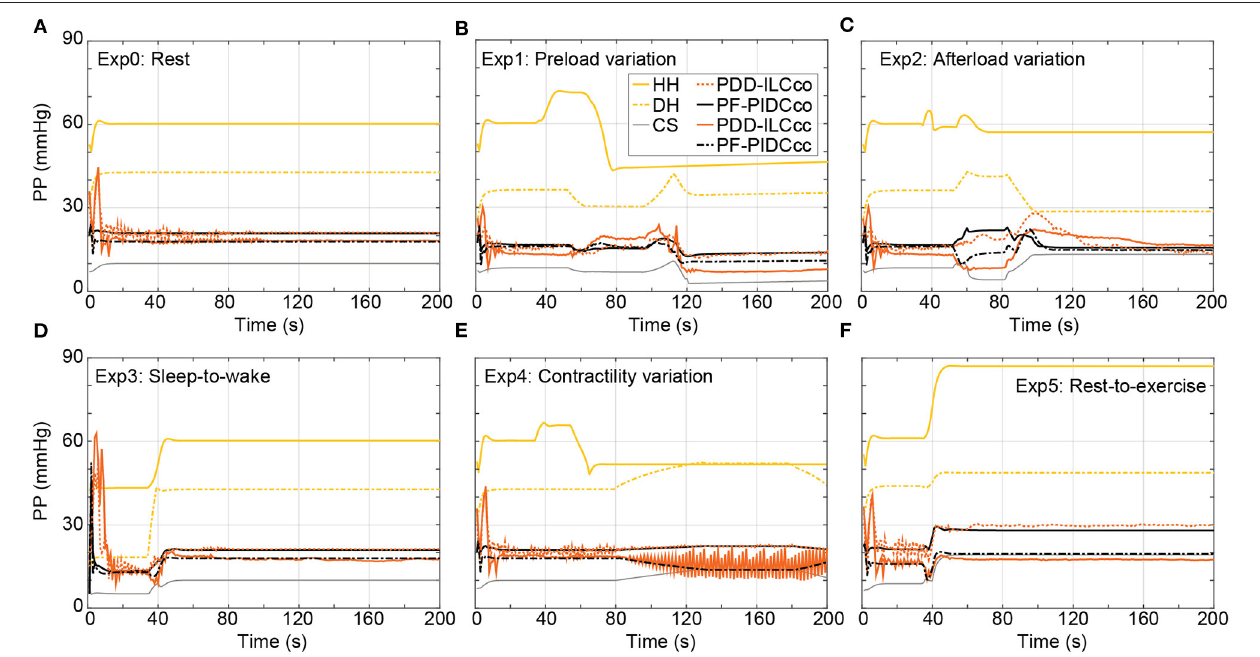
FIGURE 10 | Influence of the copulsation and counterpulsation modes on the aortic pulse pressure (PP) of the diseased heart (DH) during: (A) Rest-conditions (Exp0), (B) Preload variation (Exp1) (C) Afterload variation (Exp2) (D) Sleep-to-wake (Exp3) (E) Contractility variation (Exp4) (F) Rest-to-exercise (Exp5). HH, healthy heart; DH,